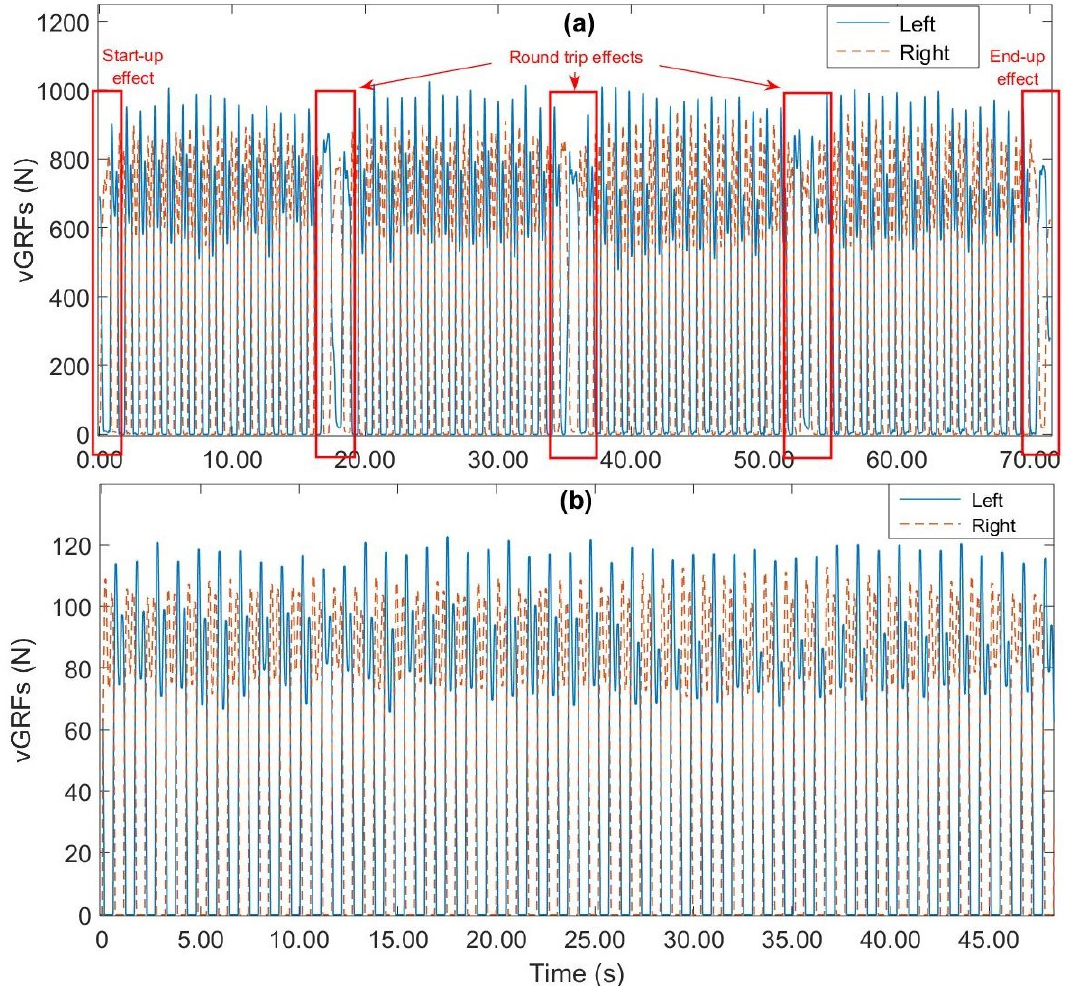
Figure 4. Example of vGRF data pre-processing; ( a ) raw vGRFs data; ( b ) processed vGRF